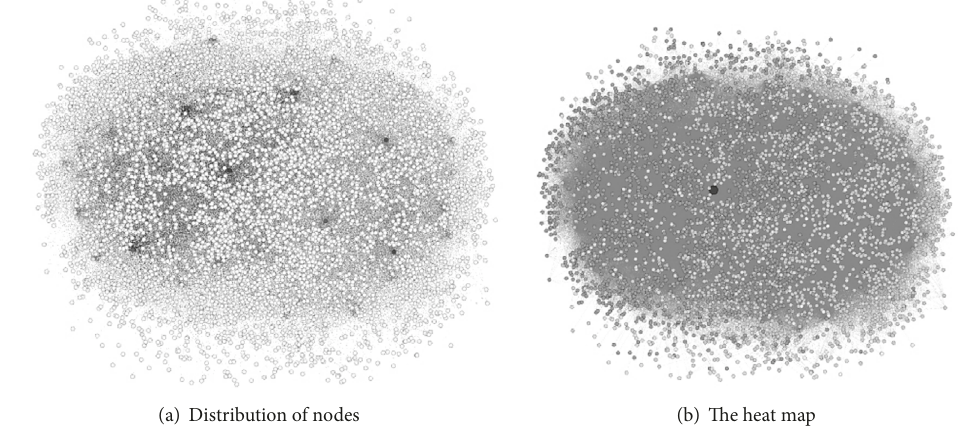
Figure 4: Visualization of the results generated by the algorithm.